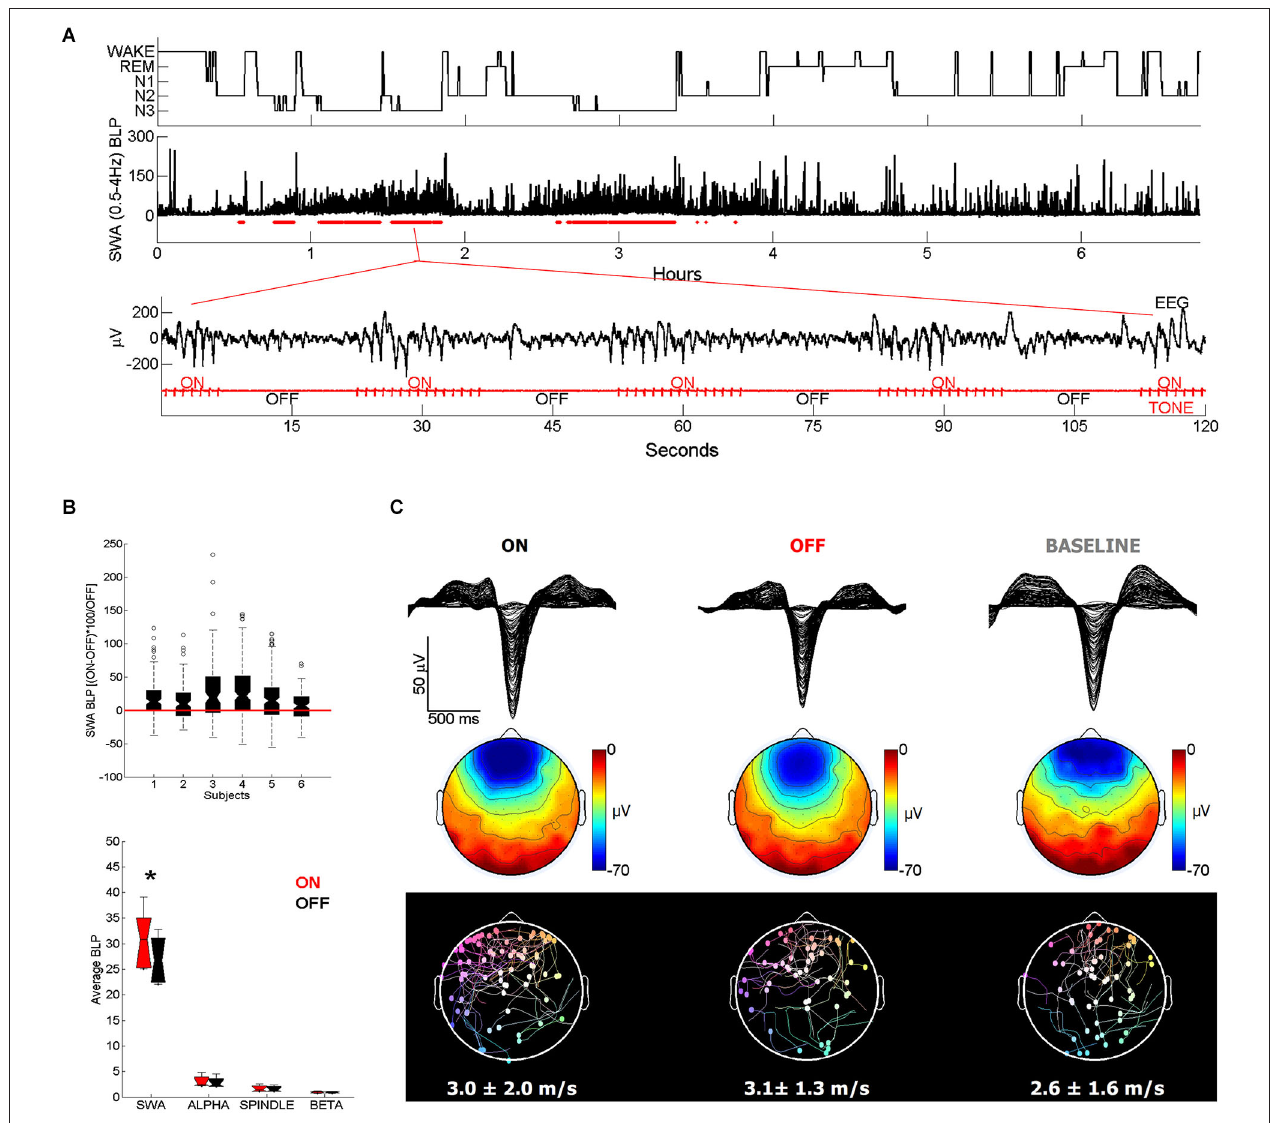
based on a paired t -test, Bonferroni corrected for multiple comparisons ( p < 0.0125). (C) Top plot shows a butterfly plot (all channels overlaid) averaging across all 100 slow waves aligned by the negative peak. Slow waves were randomly selected for comparison from the ON and OFF periods of the stimulation night and from a BASELINE (no stimulation) night. Middle plot shows the average scalp voltage topography at the negative peak. Bottom plot shows the traveling of individual waves and their average speed below. Each dot represents the origin of the wave and the line describes its traveling. Slow waves were detected globally based on standard criteria and traveling was calculated from the negative peak lag distribution of each wave (Siclari et al.,